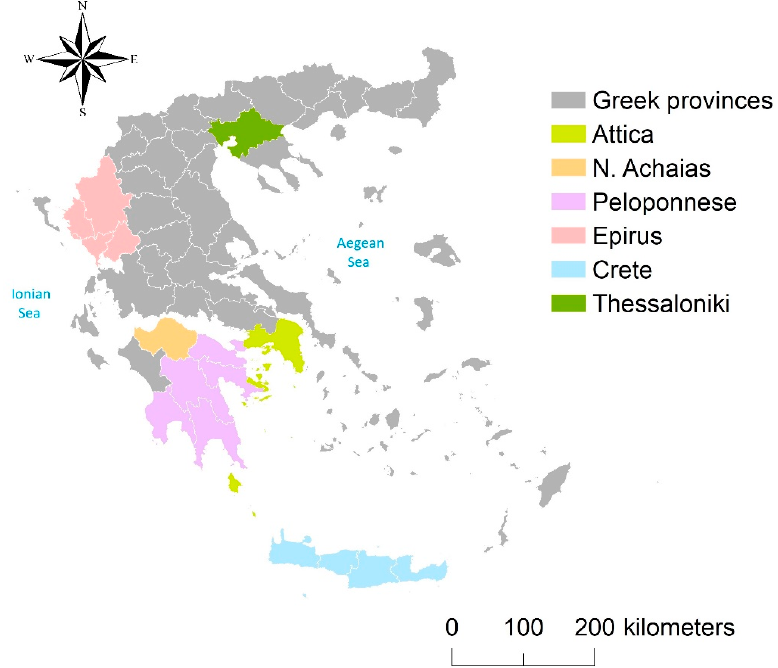
Figure 1. Map of Greek prefectures (nomarchiaka diamerismata) and other relevant locations in Greece.